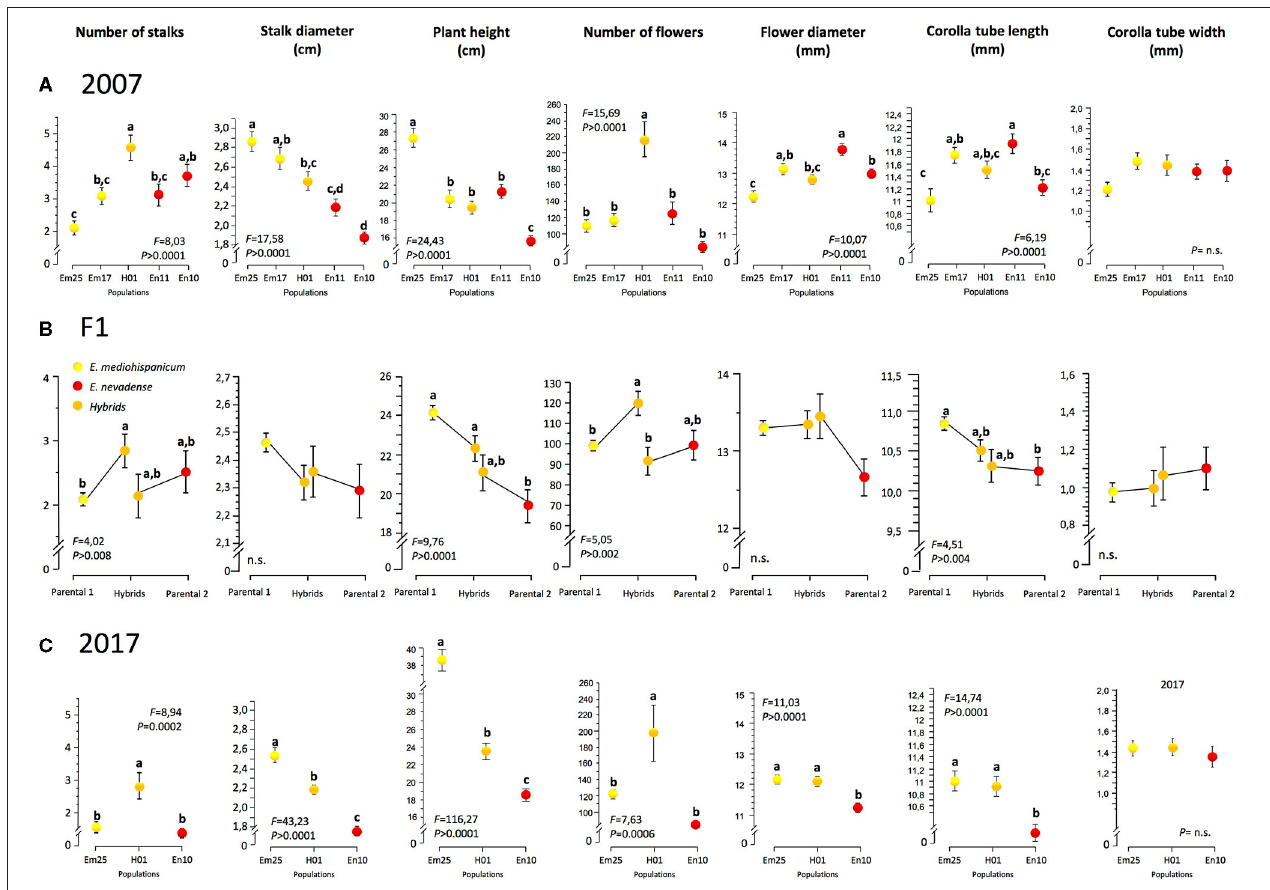
FIGURE 2 | Values of phenotypic traits at each population in 2007 (A) , 2017 (C) , and the hybrid and parental plants obtained by controlled cross experiments (B) . Yellow dots denote plants or populations of Erysimum mediohispanicum , orange dots denote the hybrid plants or population, and red dots denote plants or populations of Erysimum nevadense . F-ratios refer to one-way ANOVAs. Letters indicate the groups of plants where the differences are significant, according to Tukey’s HSD comparison.